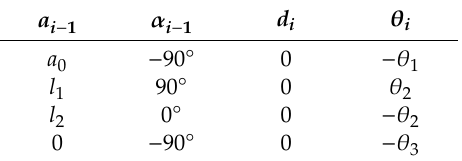
Table 2. Denavit-Hartenberg (D-H) parameters of the linkage ABC.